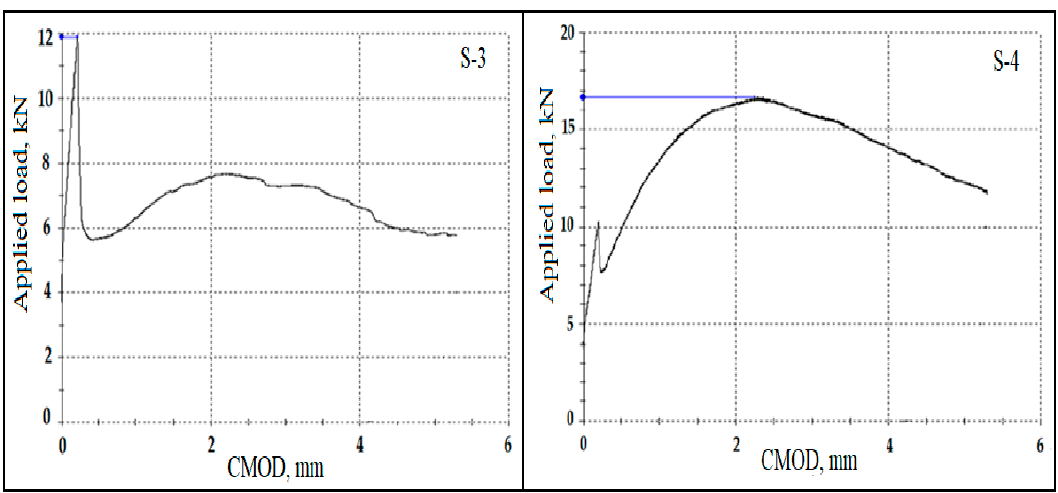
Figure 7. Load ‐ CMOD curves of S ‐ 1 and S ‐ 2.